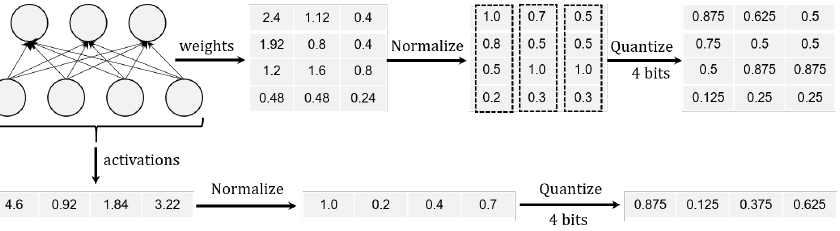
Figure 5. A normalized linear quantization flow regarding weights and